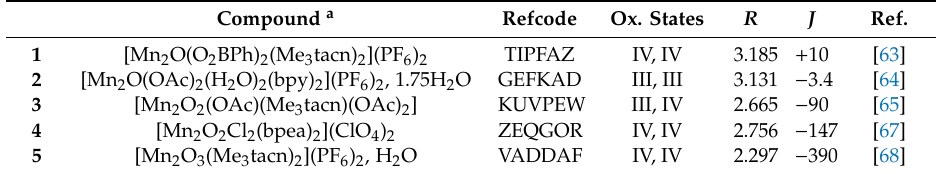
Table 1. Dinuclear manganese complexes considered in this study, with their crystallographic identifiers, Mn oxidation states, Mn ··· Mn distance R (in Å), and exchange coupling constant J (in cm − 1 ). Compound a Refcode Ox. States R J